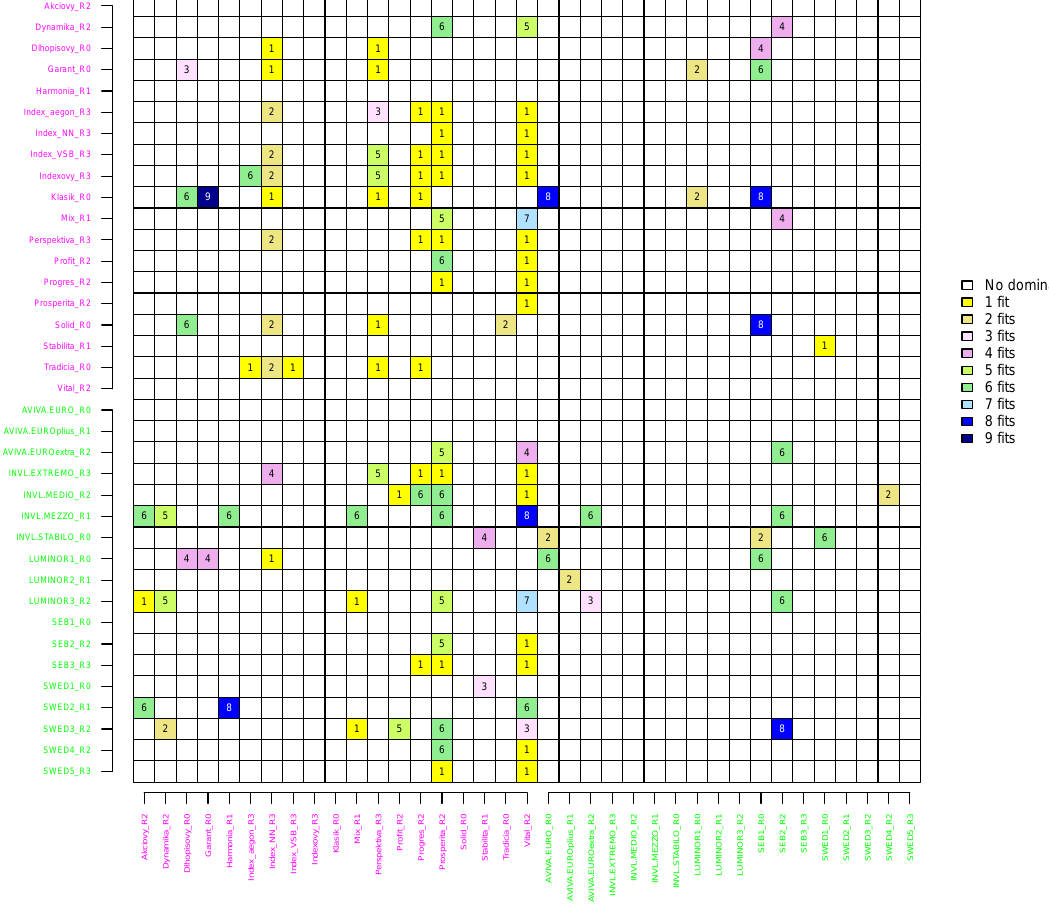
Figure 11. SD for all PFs assuming all considered